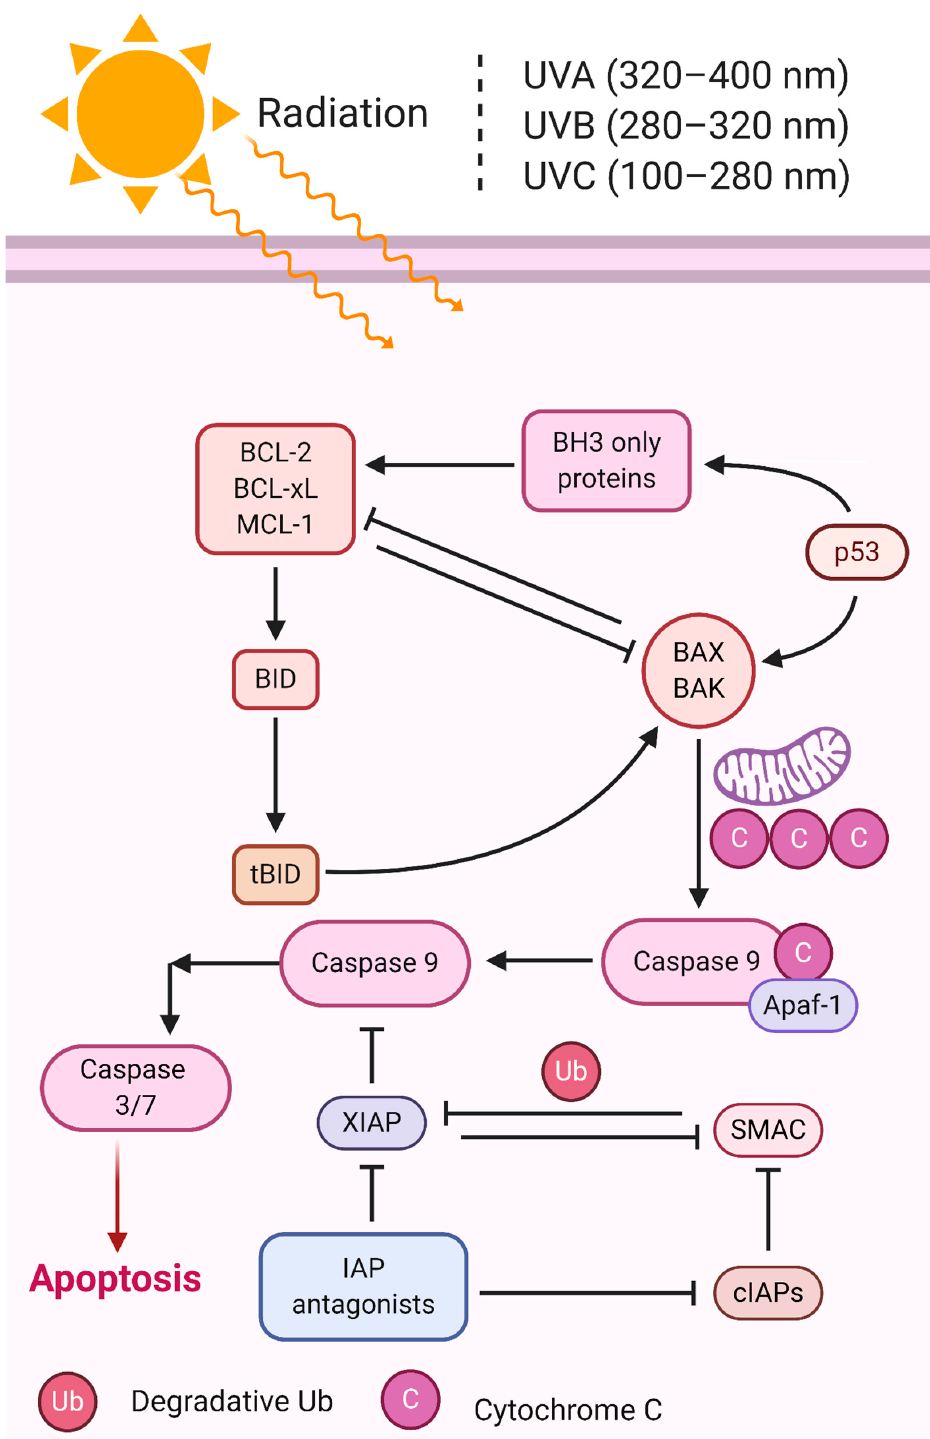
Figure 4. Intrinsic pathway of cell death via apoptosis upon uncontrolled exposure to harmful radiations. The figure was created with “BioRender.com” template and exported under the terms of premium subscription.